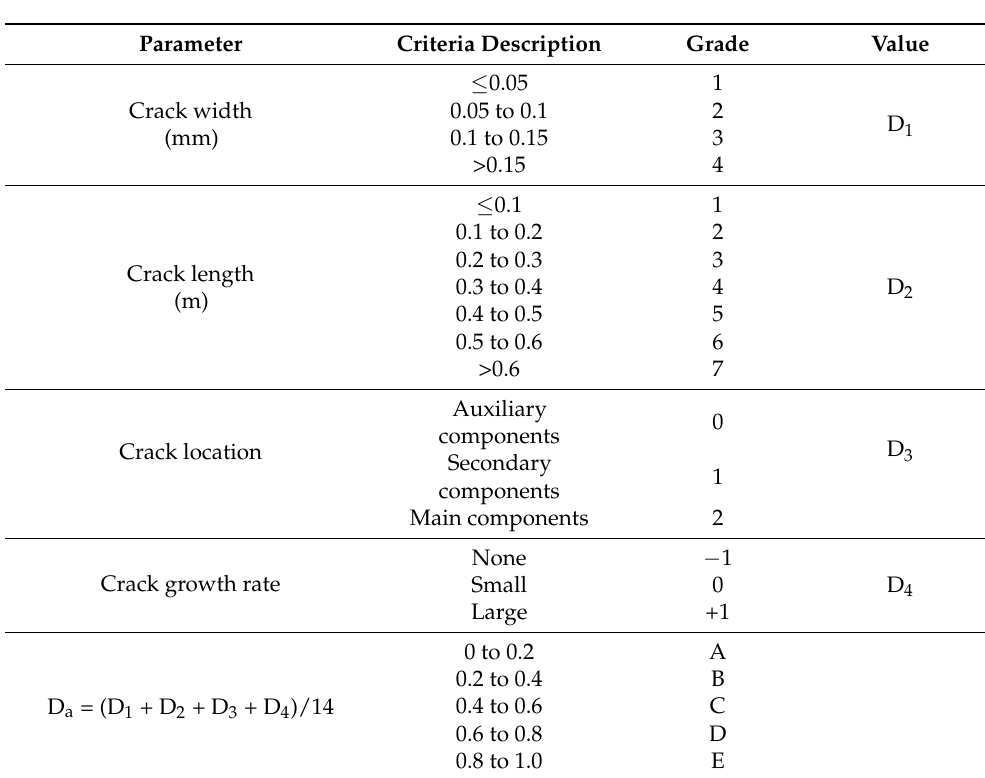
Table 3. Evaluation criteria of the surface